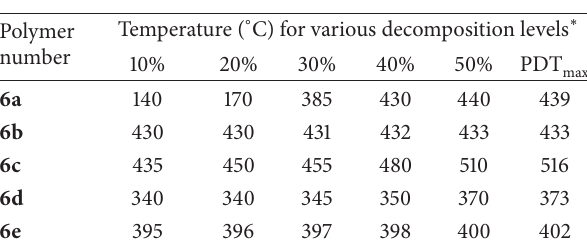
Table 2: Thermal properties of Fc-polyazomethines 6a , 6b , 6c , 6d , and 6e